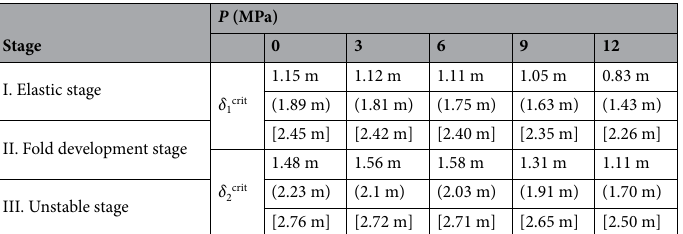
Table 3. δ crit under different fault types and P. a ( b ) [ c ]. a , b , c are δ crit under the oblique-reverse, strike-slip and reverse fault displacement,